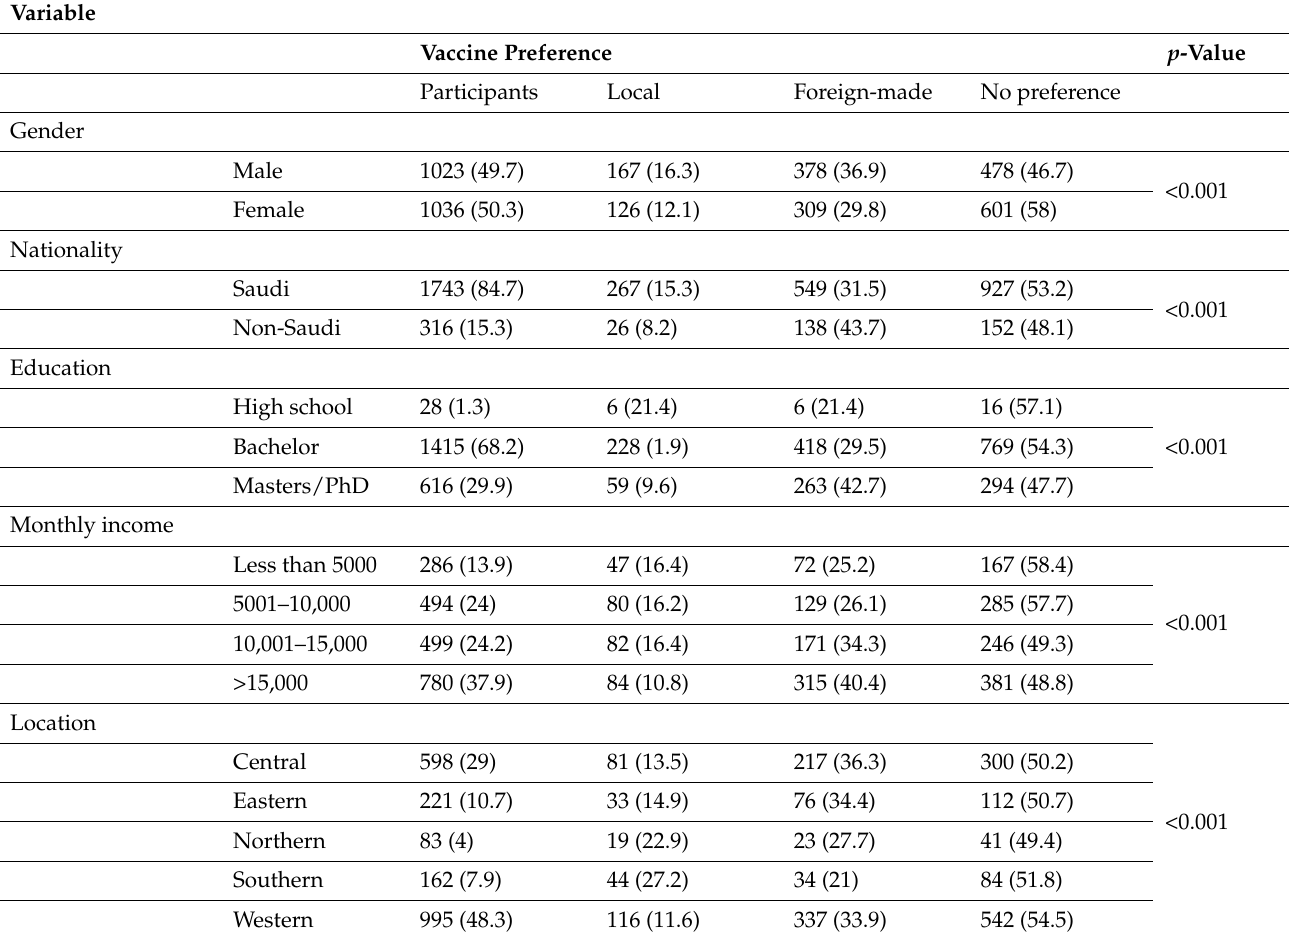
Table 2. Association between vaccine preferences and socio-demographic